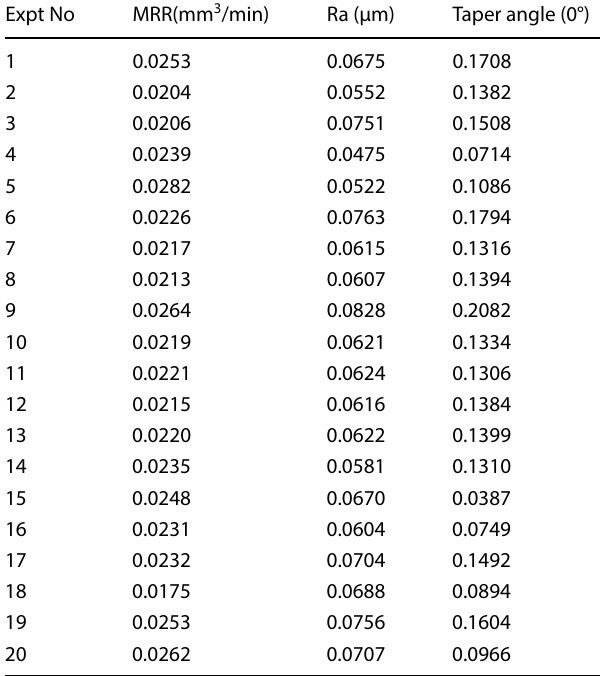
Table 9 Determination of weighted normalized